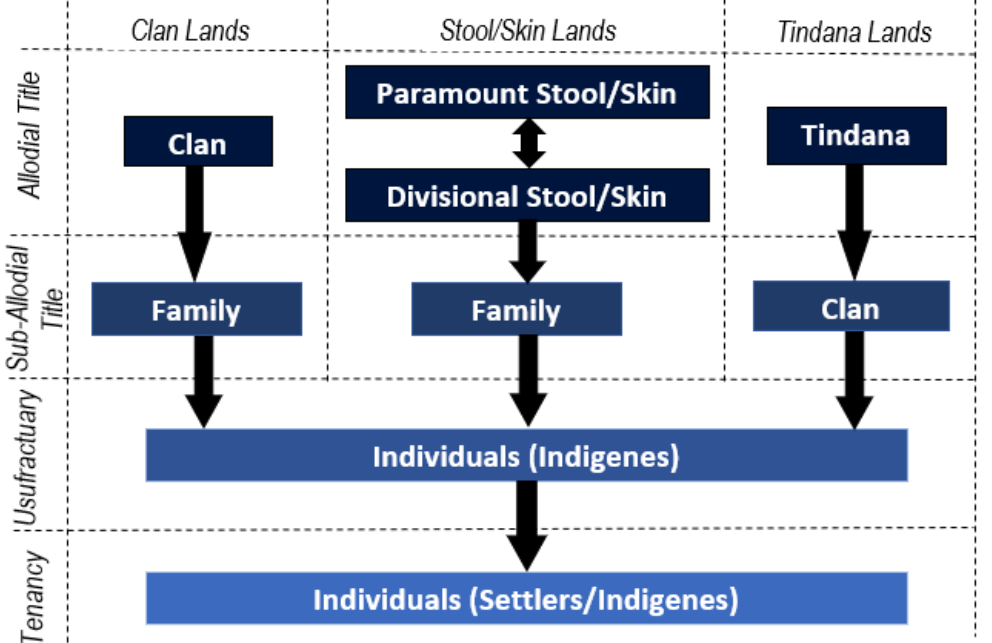
Figure 3. Hierarchy of land tenure types in Ghana [35].